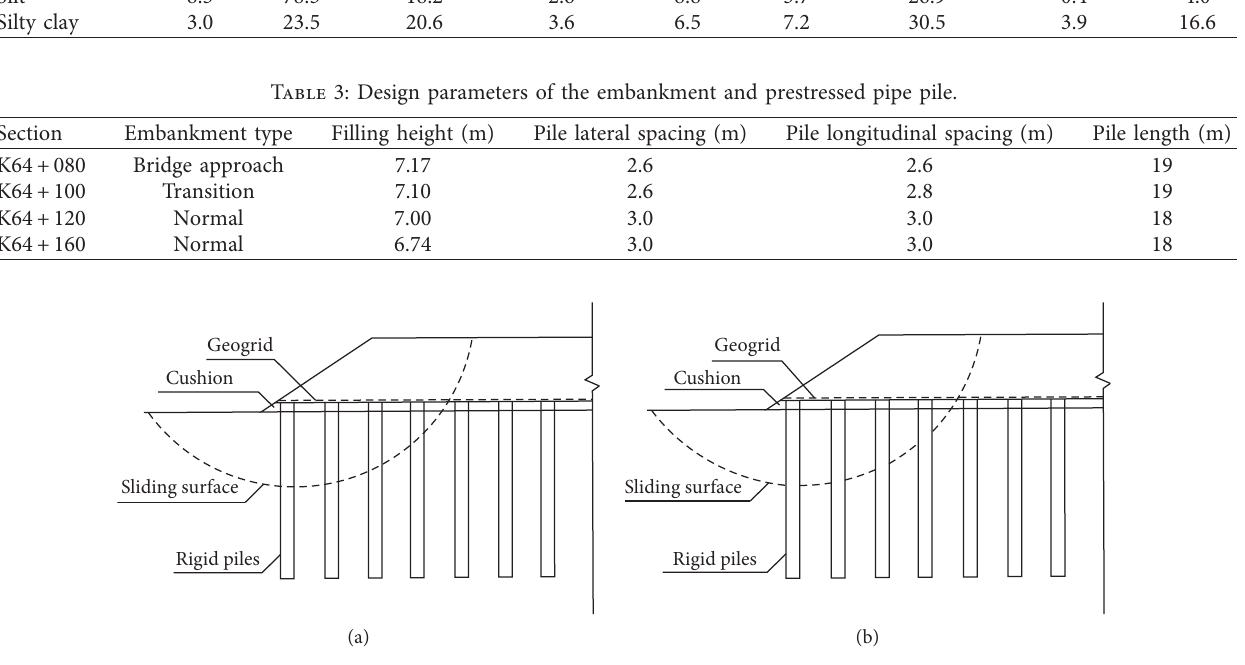
Figure 4: Schematic diagram of general shear failure and flow sliding failure. (a) General shear failure. (b) Flow sliding failure.